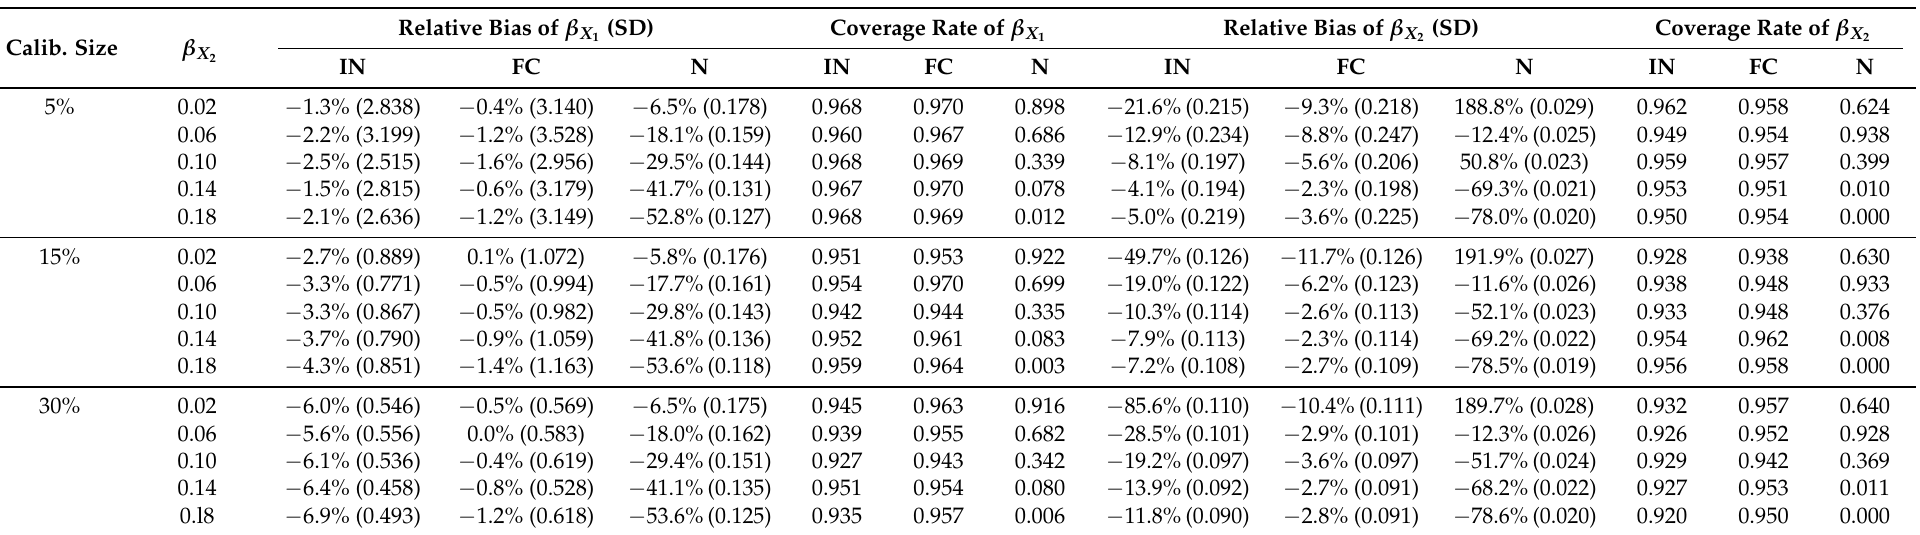
(cid:16) (cid:17) = β + β ( X ) + β ( X ) for Internalized calibration (IN), Full Y sji = 1 | X sji under the model P X 1 f 1 X 2 f 2 sji sji 0 sj X − β , and the reported value in the table is the average over the 1000 simulation replicates. β is fixed at − log ( 1.5 ) . 1